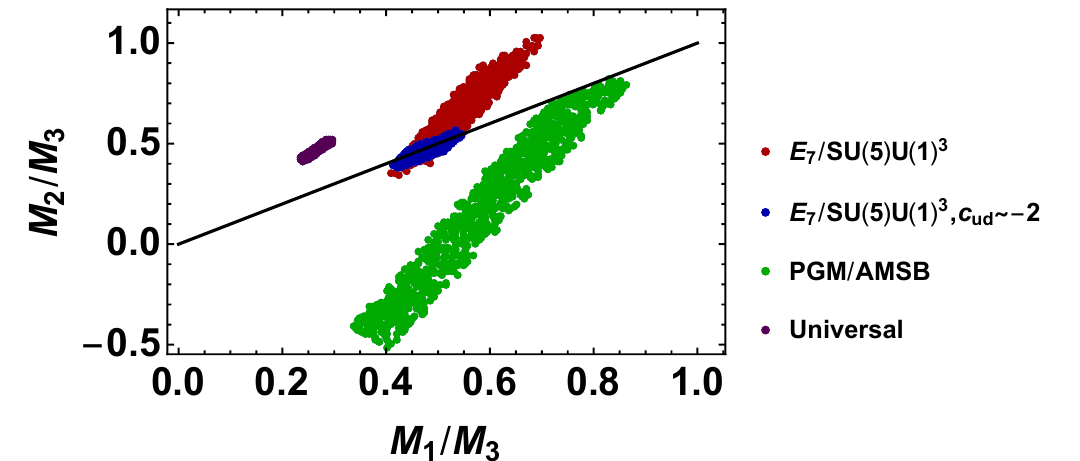
Figure 1 . The gaugino mass relation in various mediation mechanisms. The red and blue points correspond to our scenario, where we have varied (cid:0) 3 < c u;d < 3 and c u + c d = (cid:0) 4 (cid:6) 0 : 8 ; respectively. On the black solid line, M 1 = M 2